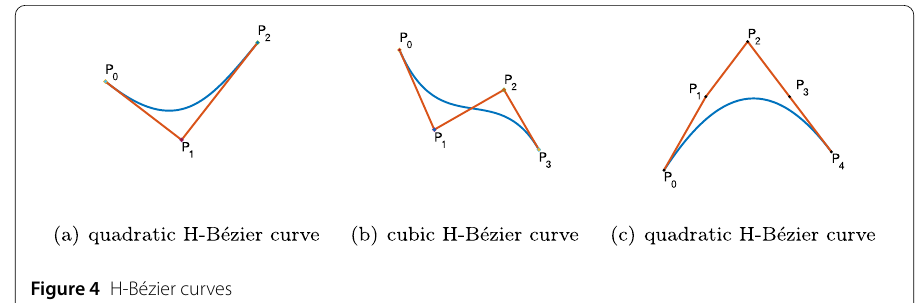
Figure 4 H-Bézier